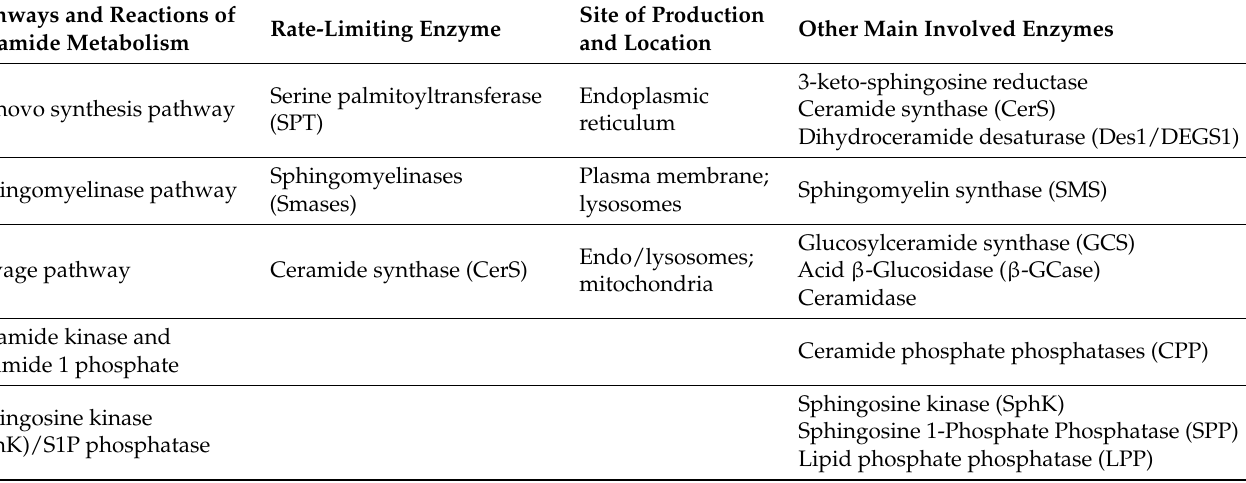
Table 1. Key pathways of sphingolipid